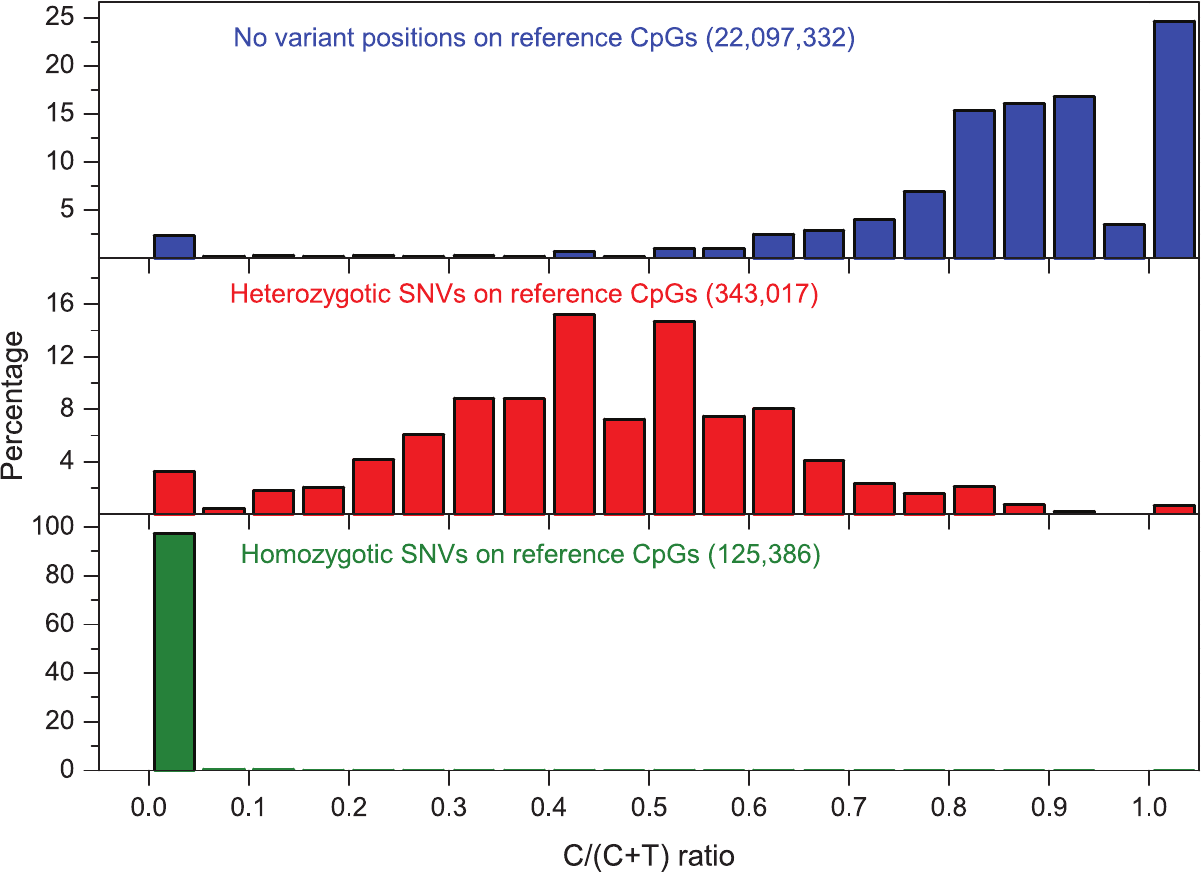
Figure 2. Distribution of C/(C+T) ratios for cytosines within the CpG context in the H1 cell line. C/(C+T) values for cytosines at non- variant and variant (homo- and heterozygotic) positions were shown. The minimum read coverage was set to 10